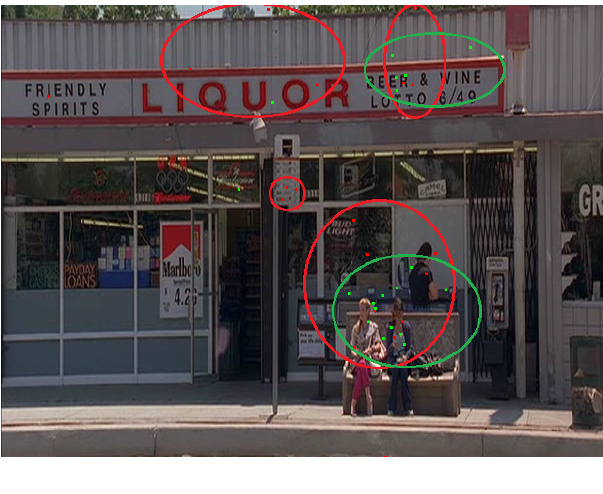
Figure 7 . An example scene depicting the different clusters. The ellipses depict the clusters of eye positions obtained from the mean-shift clustering method. Red ellipses represent the clusters extracted from color eye positions and green ellipses represent the clusters extracted from grayscale eye positions.